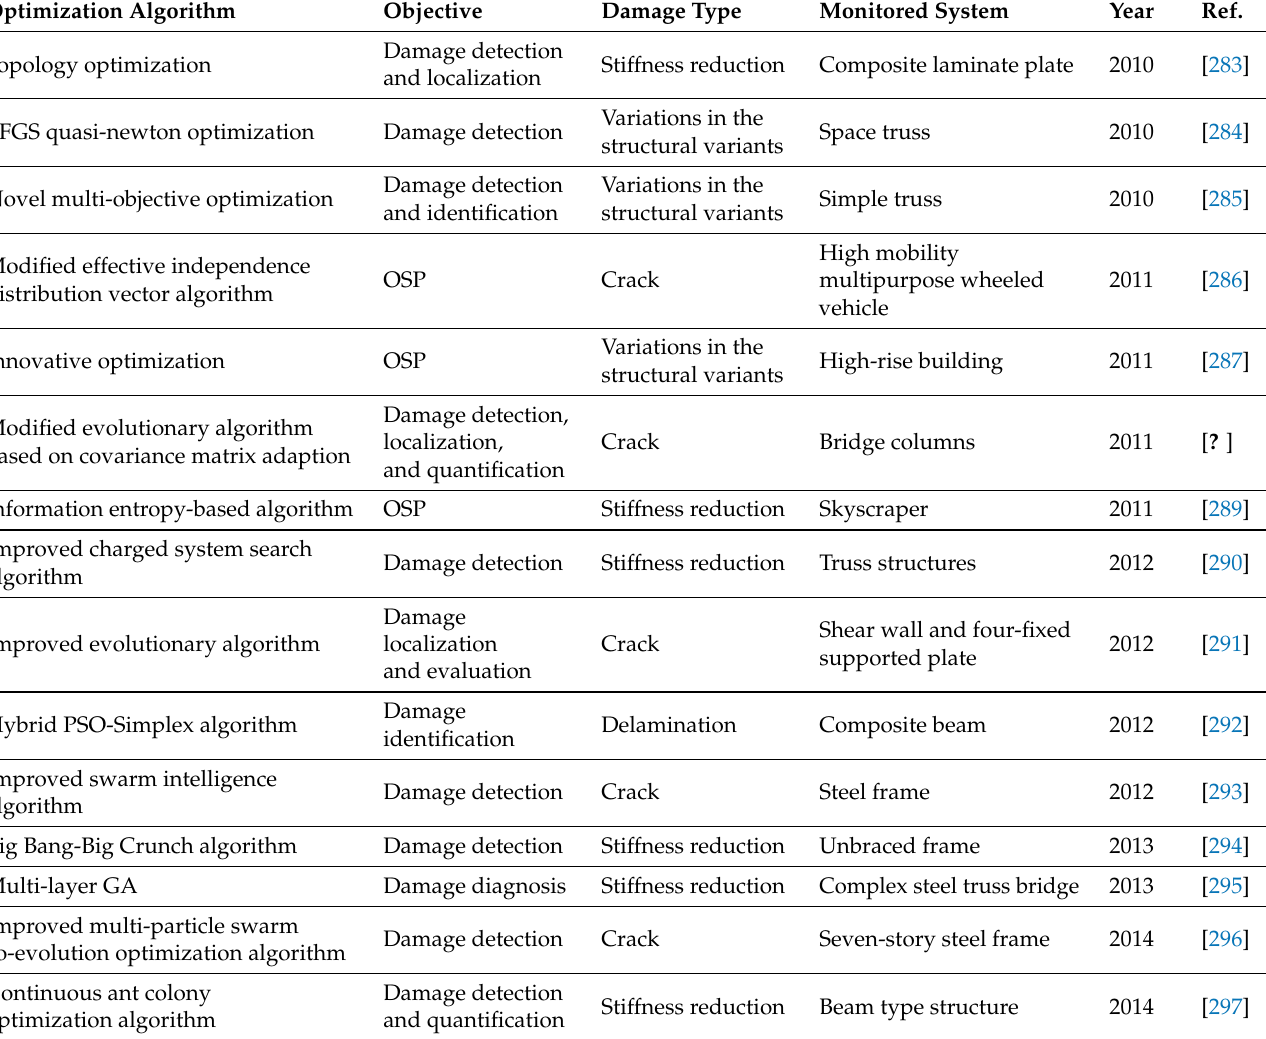
Table 17. Papers on optimization algorithms used for all levels of SHM and OSP (between